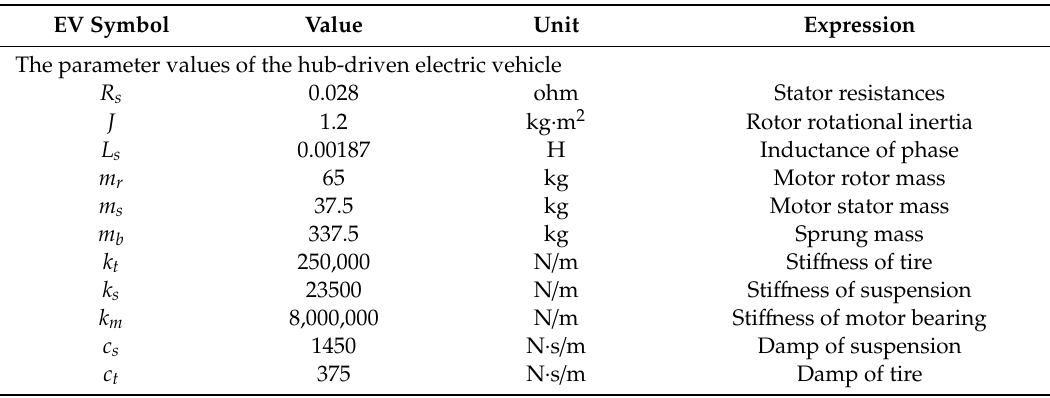
Table A1. Nomenclature and